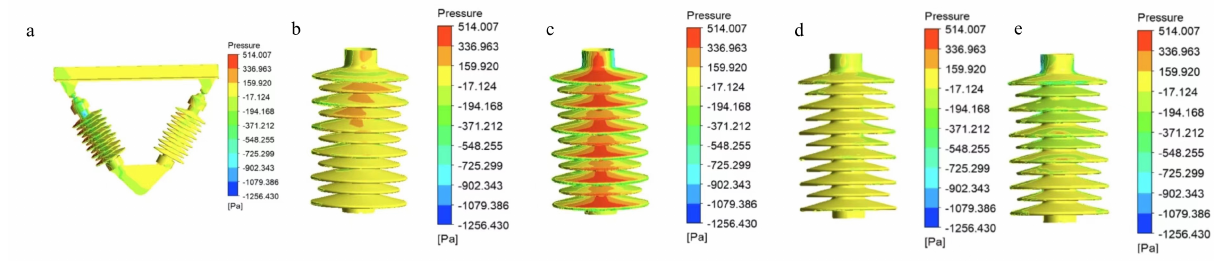
Figure 12. Static pressure distributions on the insulator surface under the wind speed of 25 m/s. ( a ) the surface pressure distributions on the crosswind side of insulators; ( b ) the surface pressure distributions on the windward surface of 2# insulator; ( c ) the surface pressure distributions on the windward surface of 1# insulator; ( d ) the surface pressure distributions on the leeward surface of 2# insulator; ( e ) the surface pressure distributions on the leeward surface of 1#